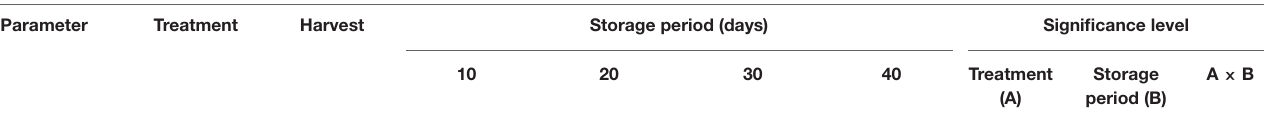
TABLE 2 | Total phenolic (TPC), total flavonoid (TFC), and ascorbic acid (AA) content of ‘Kinnow’ mandarin fruit treated with gum arabic coating fused with zinc oxide nanoparticles during storage for 40 days at 5 ± 1 ◦